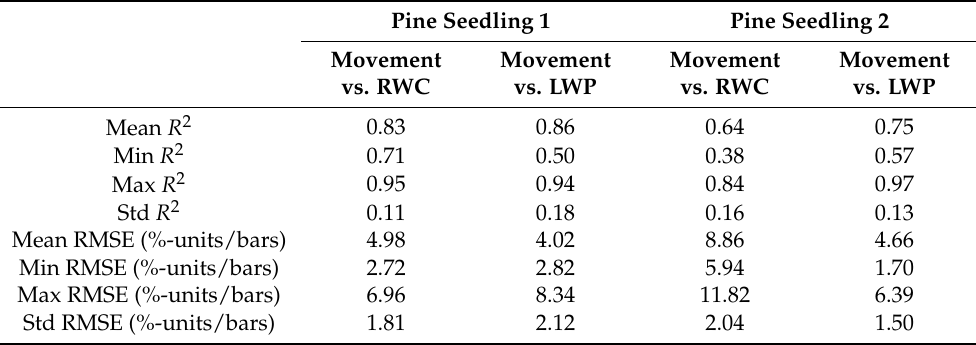
Table 2. Summary of statistics for linear regression models for individual branches between relative water content (RWC), leaf water potential (LWP) and branch movement for Scots pine. Mean, minimum (Min), maximum (Max) and standard deviation (Std) for coefficient of determination ( R 2 ) and root mean square error (RMSE) calculated from six and nine branches from seedlings 1 and 2,